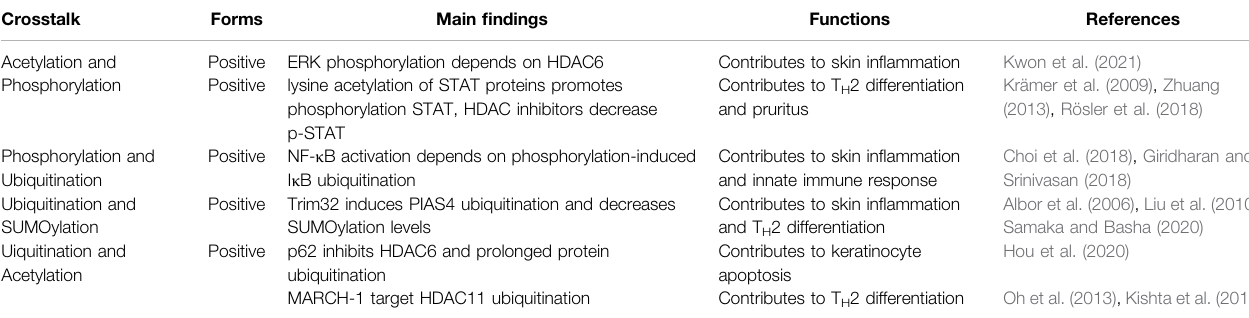
TABLE 1 | Crosstalk between post-translational modi fi cations involved in